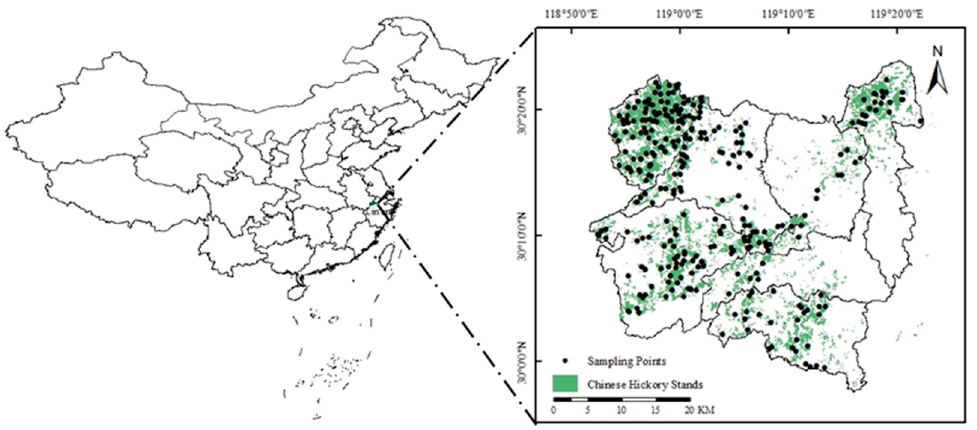
Figure 1. Location of the study area and soil samples.